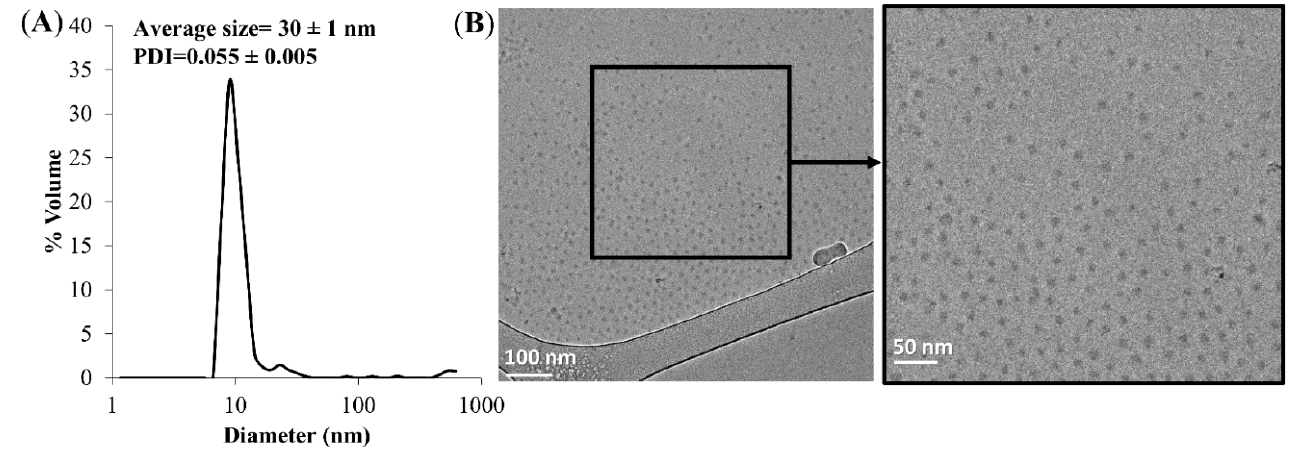
Figure 2. ( A ) Particle size distribution of APT functionalized PEG-PCL NPs. Average NP size = 30 ± 1 nm; PDI = 0.055 ± 0.005 (the measurements are based on duplicates). ( B ) Cryo-TEM image of APT- functionalized PEG-PCL